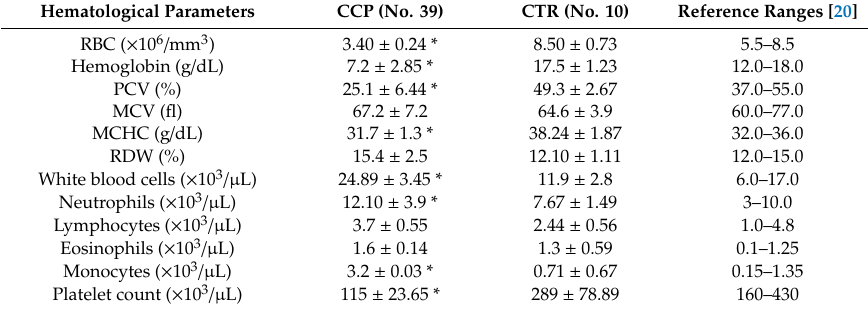
Table 1. Mean and standard deviation of hematological variables analyzed for healthy bitches (CTR) and animals with closed cervix pyometra